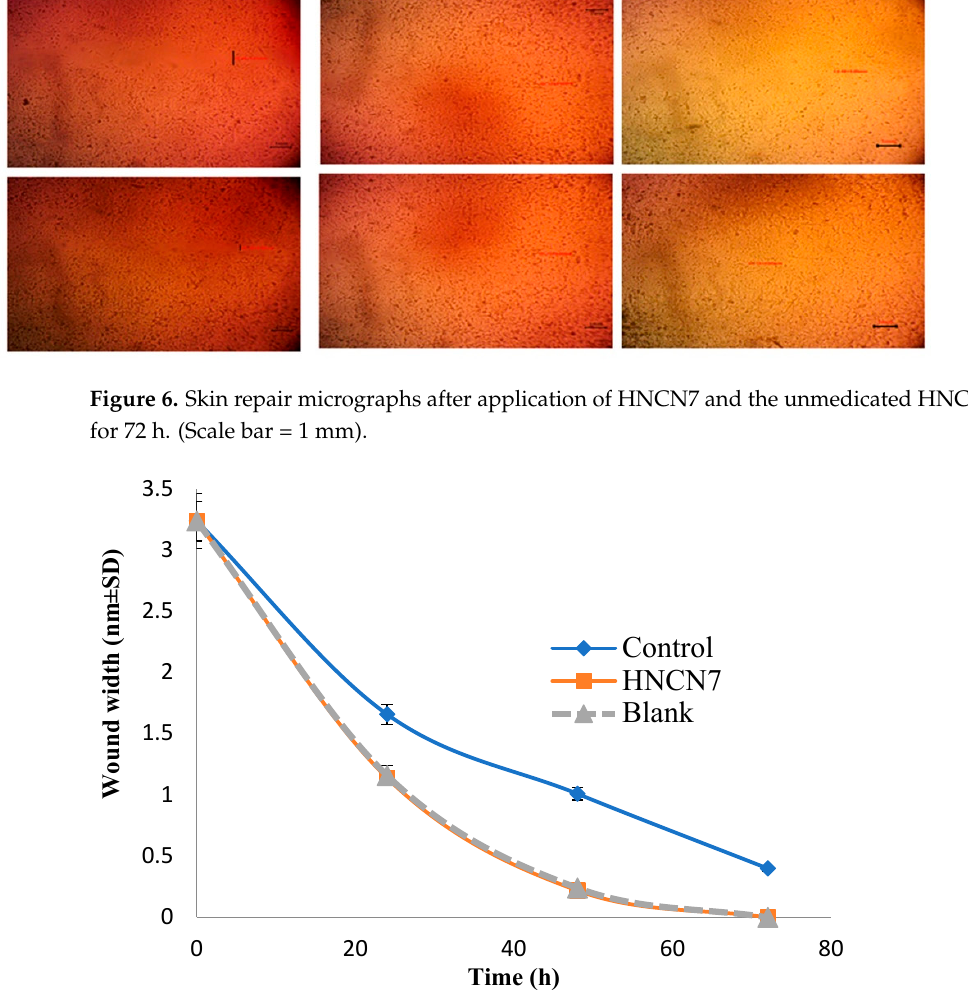
Figure 7. Scratch width area after application of HNCN7 and the unmedicated HNCN7 (blank).